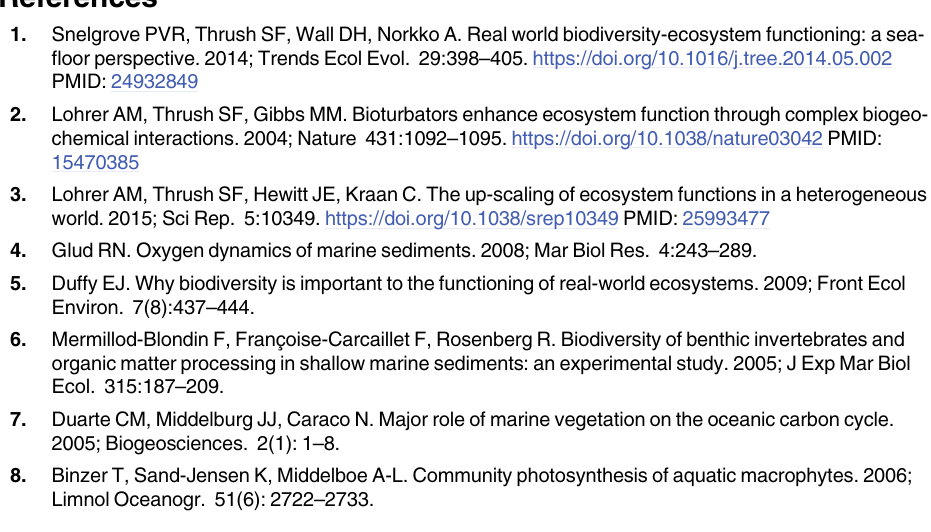
S1 Fig. Average percent cover ( ± SE) of the main biodiversity components. Pictures taken at the five study habitats using quadrats (25 x 25 cm, n = 24 per habitat) placed along the guide- lines (at 1, 3 and 5 m), and estimated by a supervised image classification technique (ArcGIS 10.1, ArcMap). Pictures showed here are random examples of the total number of photographs taken. MPB: microphytobenthos. F . vesiculosus : Fucus vesiculosus .